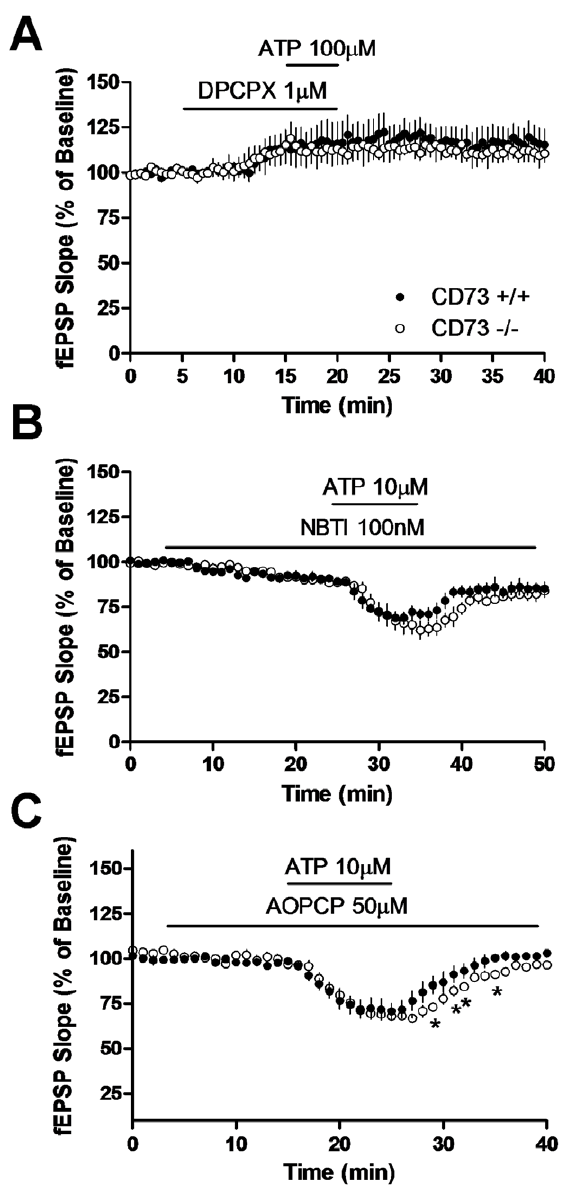
Figure 5. DPCPX and NBTI, but not AOPCP, affect inhibition of fEPSPs by ATP. Hippocampal slices from CD73 + / + and CD73 2 / 2 mice were superfused with (a) 1 m M DPCPX, (b) 100 nM NBTI or (c) 50 m M AOPCP as indicated by the horizontal lines. After 10 min (a, c) or 20 (b) min, 100 m M ATP was applied as indicated by second horizontal line. n =3–4 CD73 + / + and 3–4 CD73 2 / 2 . * p , 0.05; two tailed t -test.